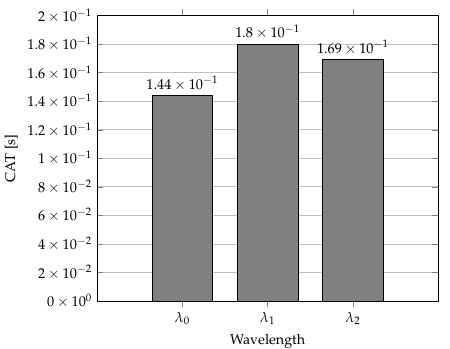
Figure 3. CAT parameter values in s for wavelengths in cycle No. 100 using Method